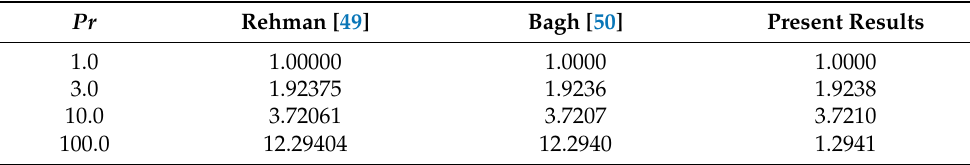
Table 2. Comparing the current numerical findings for Pr when and all others parameter are